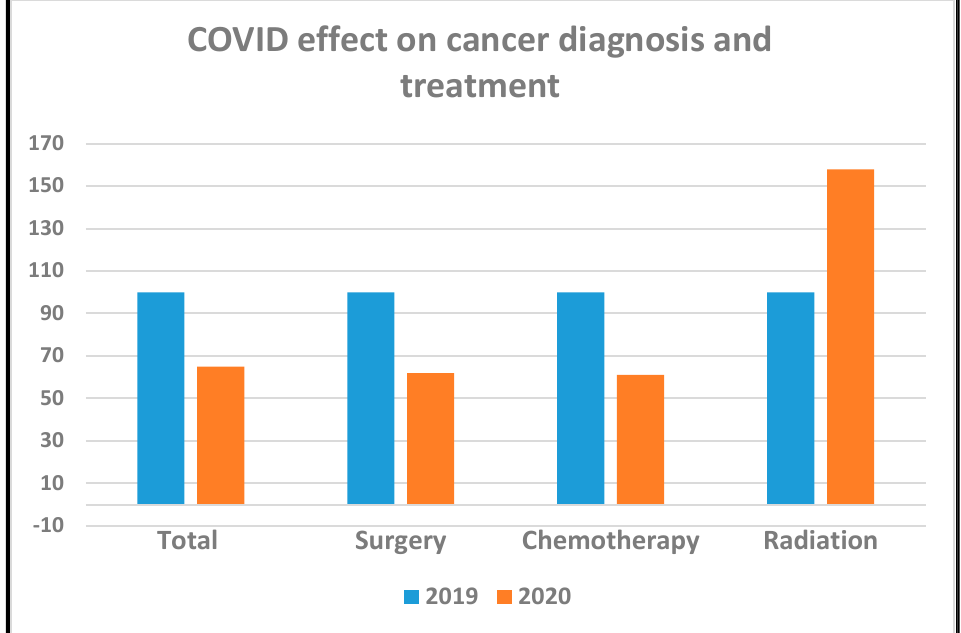
Figure 2. Major effect of COVID–19.